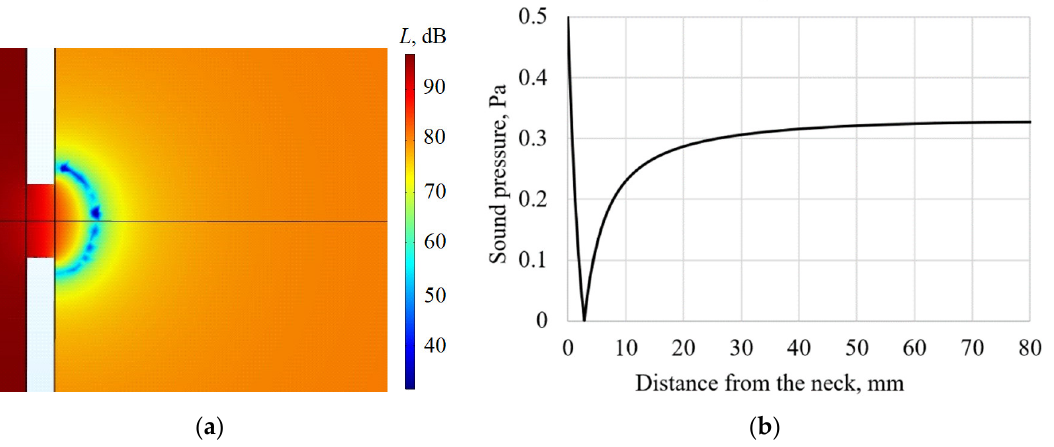
Figure 2. Sound pressure distribution in the longitudinal plane of the resonator ( a ) and change in sound pressure along its longitudinal axis ( b ).